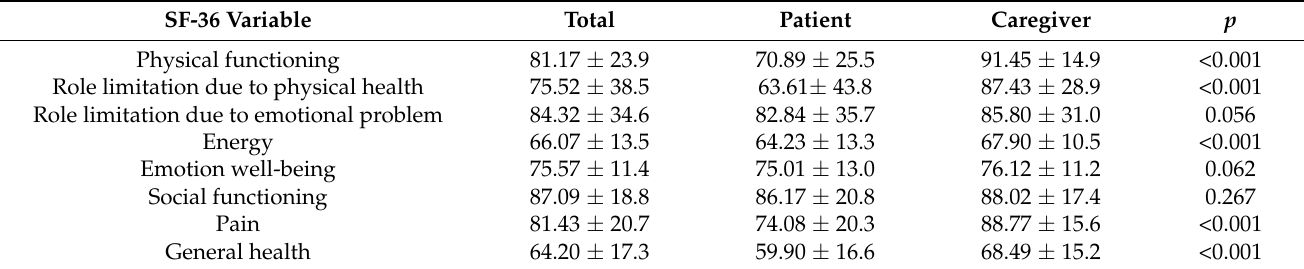
Table 7. Comparison of 8 domains of SF-36 between patients and